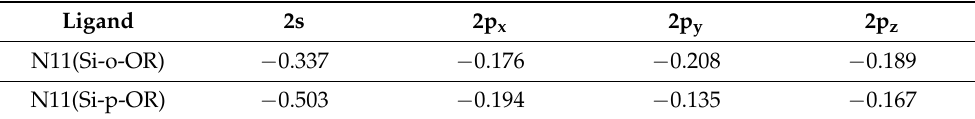
Table 11. VO energies of N11 for Si-o-OR and Si-p-OR (in a.u.). Ligand 2s 2p x 2p y 2p z N11(Si-o-OR) − 0.337 − 0.176 − 0.208 − 0.189 N11(Si-p-OR) − 0.503 − 0.194 − 0.135 −